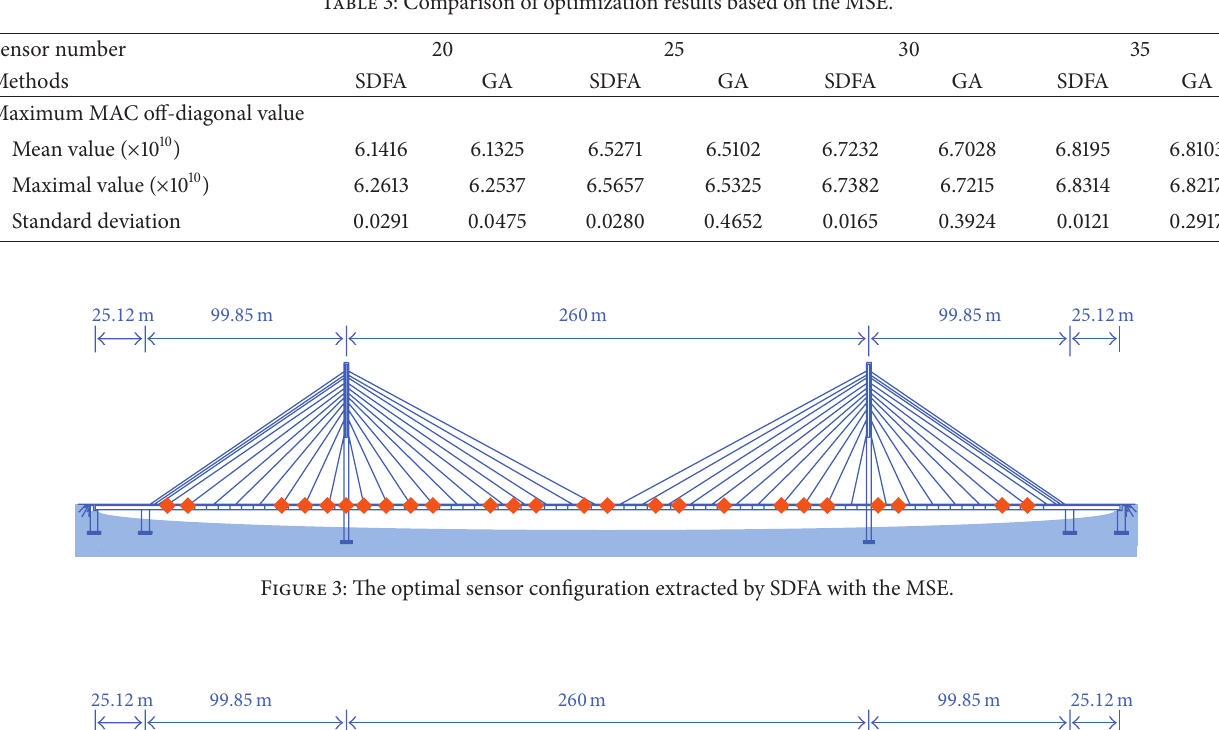
Table 3: Comparison of optimization results based on the MSE.